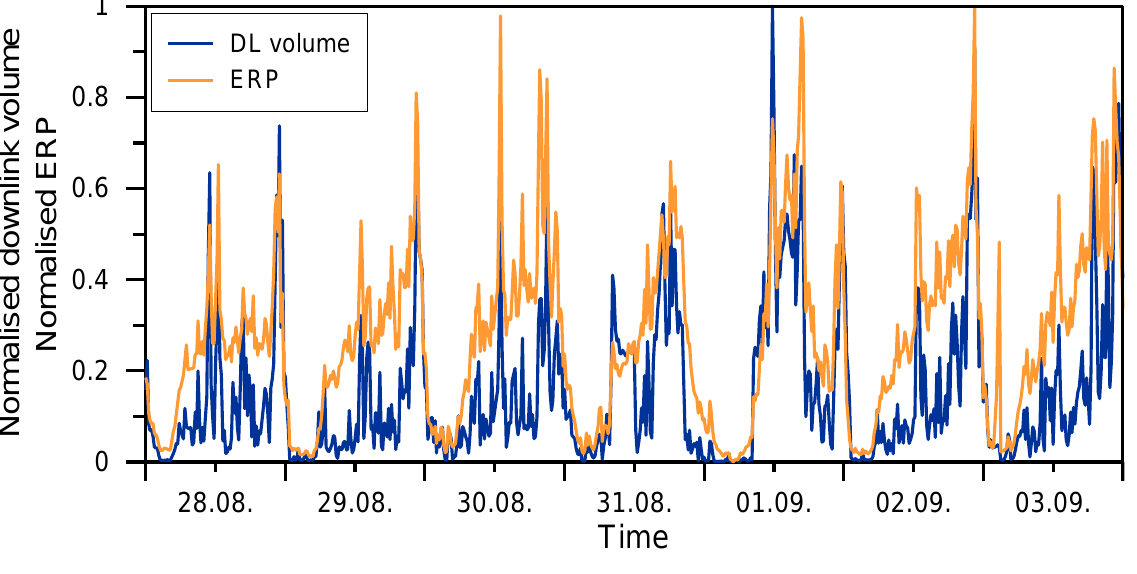
Figure 3. Comparison of the normalised downlink data volume and the normalised ERP of a UMTS cell for one week of